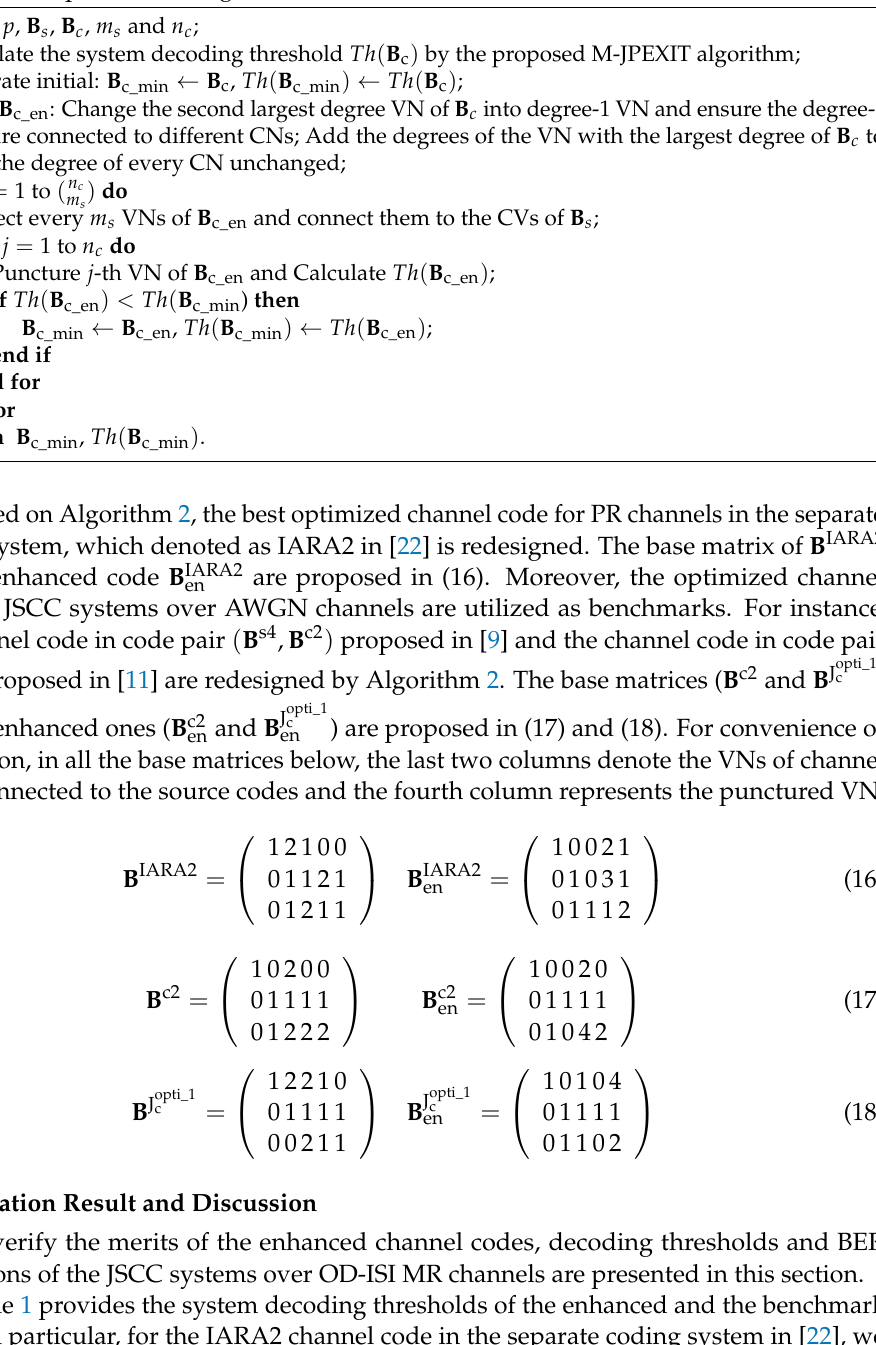
Algorithm 2 Optimization algorithm for B c